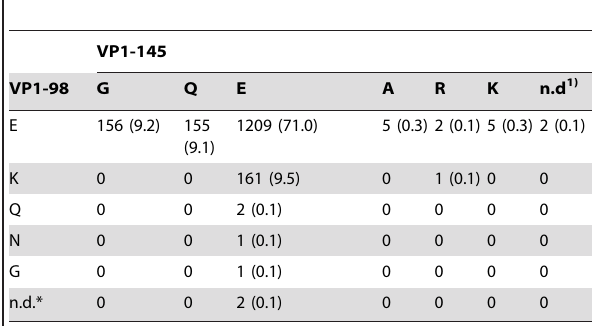
Table 2. Amino acid combinations at VP1-98 and VP1-145 in 1702 EV71 sequences found in